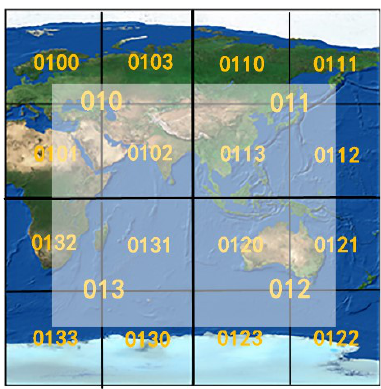
Figure 8. Vector data arrangement with the hierarchical Hilbert code. Table 2. Store schema of the hierarchical Hilbert code as the rowkey.